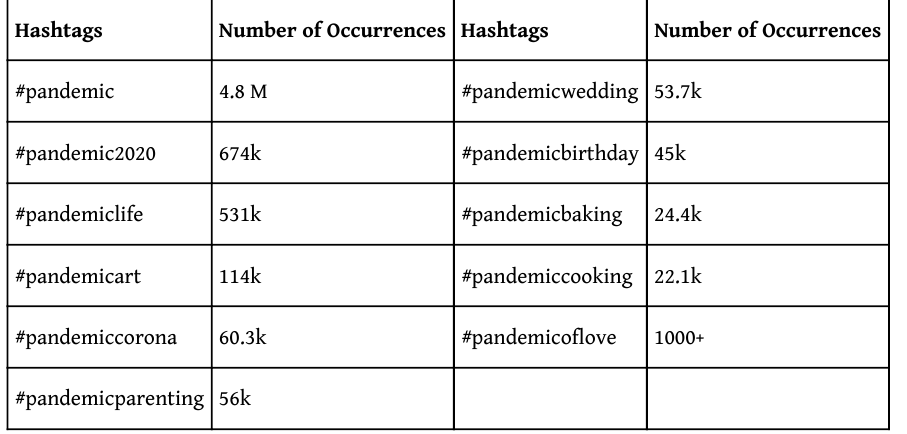
Hashtags Number of Occurrences Hashtags